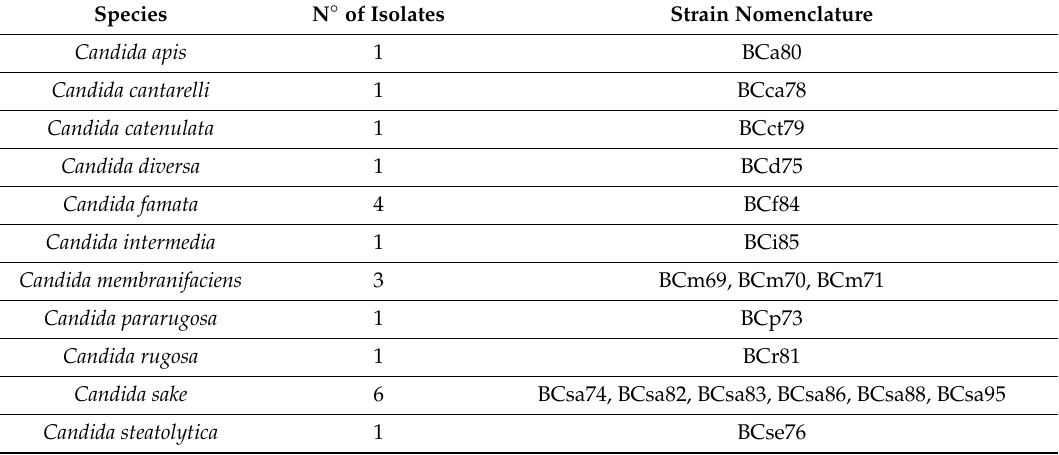
Table 1. Non- Saccharomyces yeast isolates